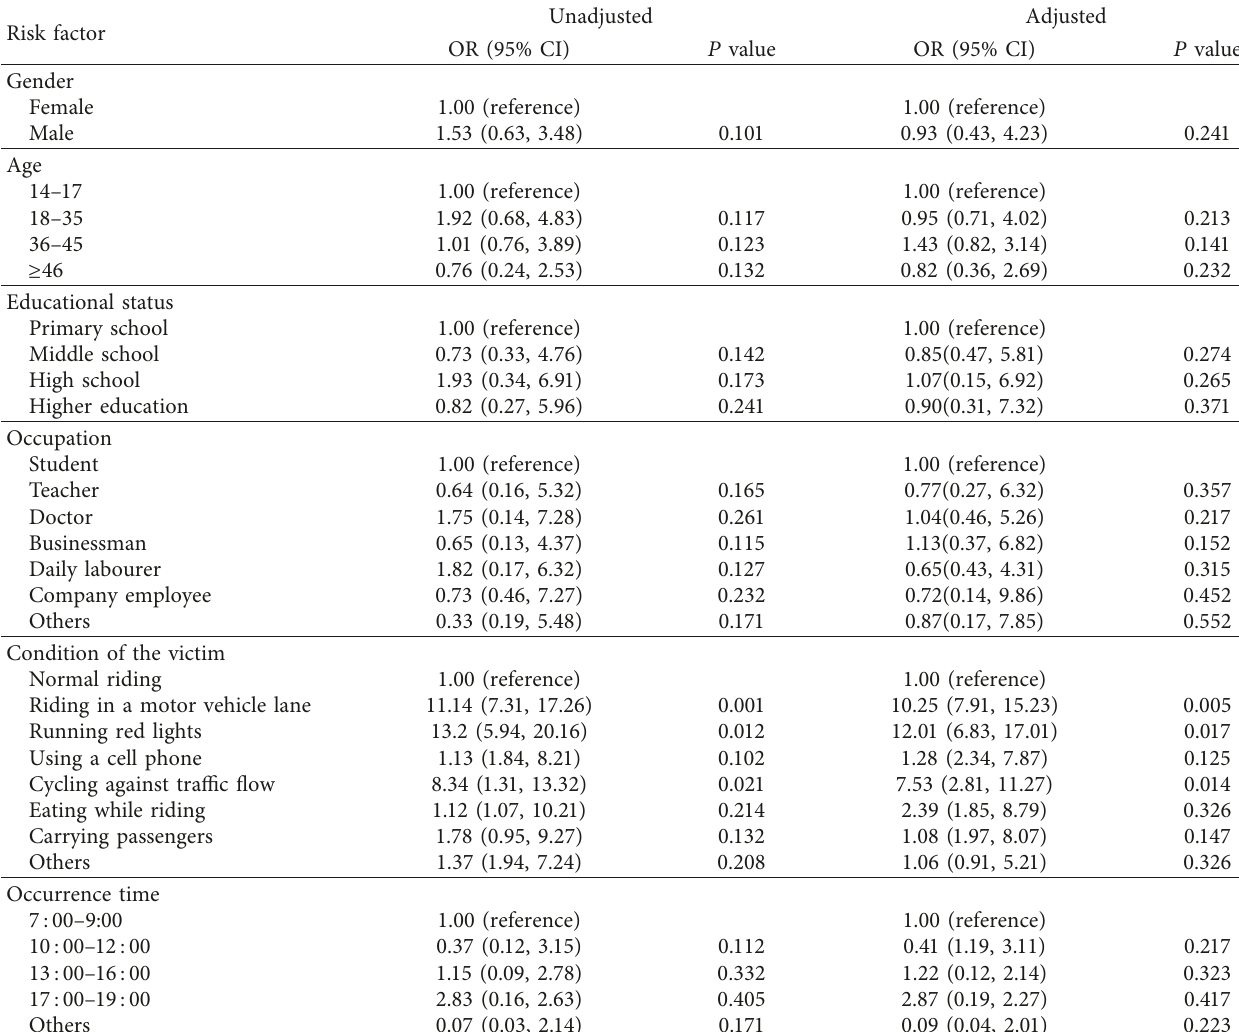
Table 5: Results of multivariate logistic regression analysis on fatal injury versus nonfatal